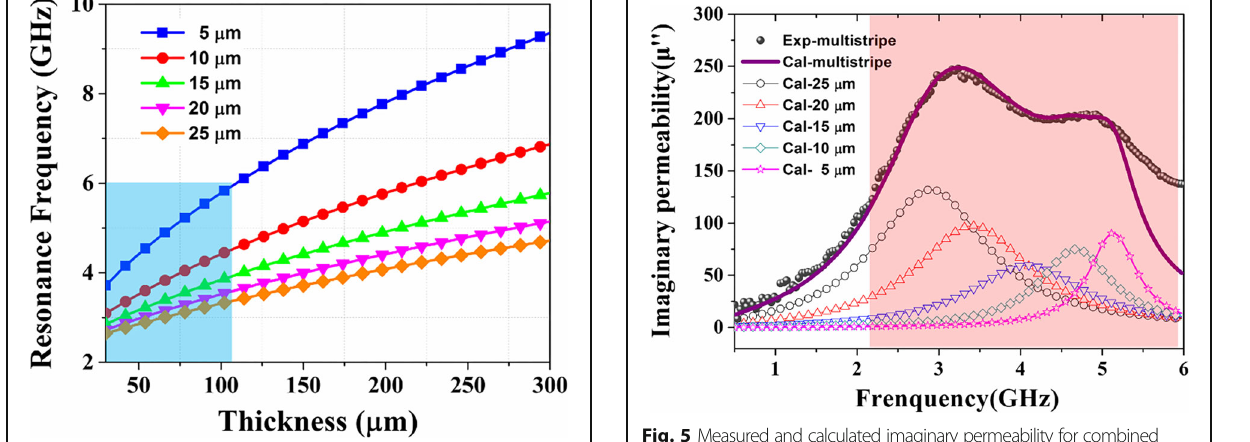
Fig. 4 Numerical calculation of resonance frequency of different stripe width dependent on different thickness. The blue area reveals the available measurement frequency range (up to 6 GHz) for our setup